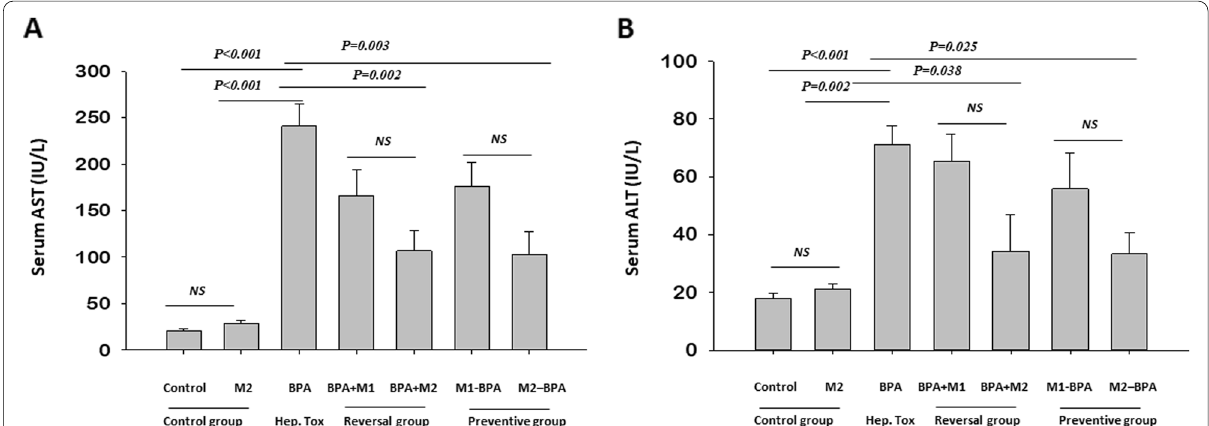
Fig. 1 Effect of Moringa oleifera on liver function test in BPA‑induced hepatotoxicity rats. Serum aspartate transaminase (AST, A ) and alanine transaminase (ALT, B ) levels were assessed in all groups. All data were presented as mean